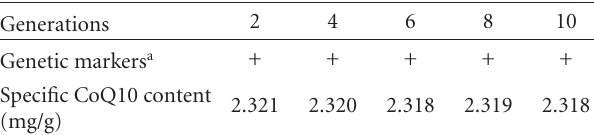
Table 2: The experiment testing genetic stability and specific CoQ10 content of